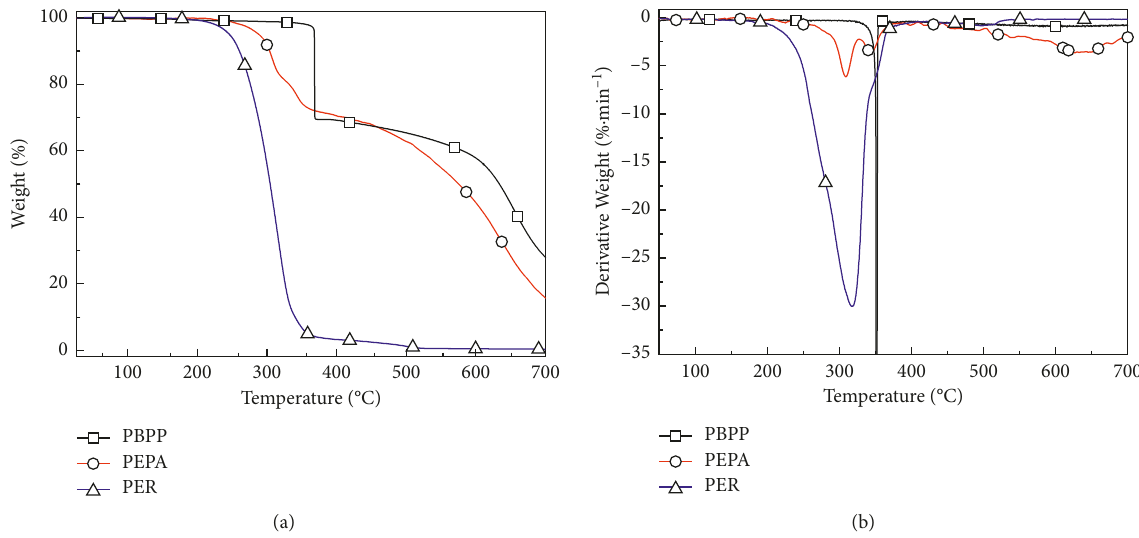
Figure 7: TG (a) and DTG (b) curves of PER, PEPA, and PBPP in